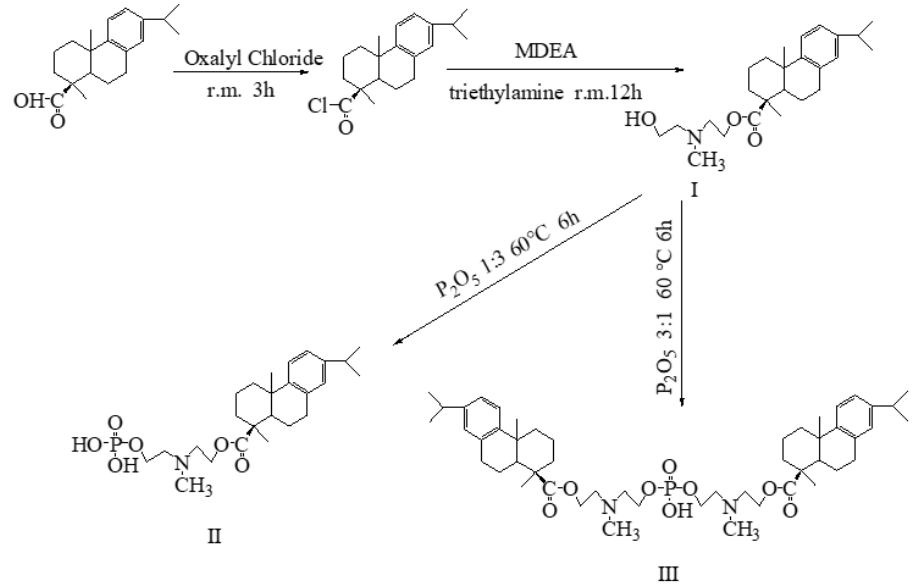
Figure 1. Synthetic routes of I (DDAM), II (DPM) and III (DPD).